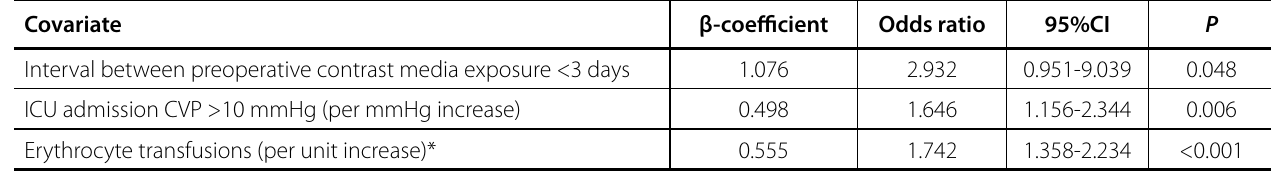
Table 2. Multivariate analysis of risk factors for the development of acute kidney injury in the matched sample. Covariate β-coefficient Interval between preoperative contrast media exposure <3 days